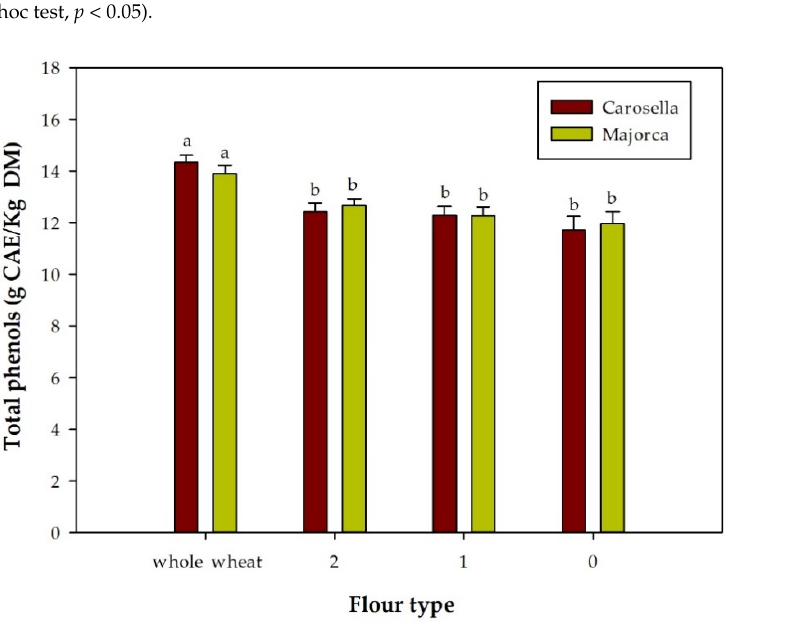
Figure 2. Total phenolic content of Carosella and Majorca samples. Data are expressed as means ± SD ( n = 3). Different letters indicate statistically significant differences (Bonferroni post hoc test, p < 0.05).